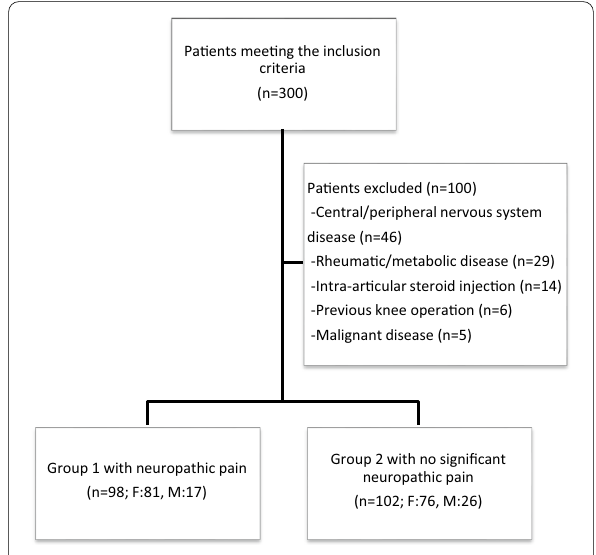
Fig. 1 Patient flowchart. n number, F female, M